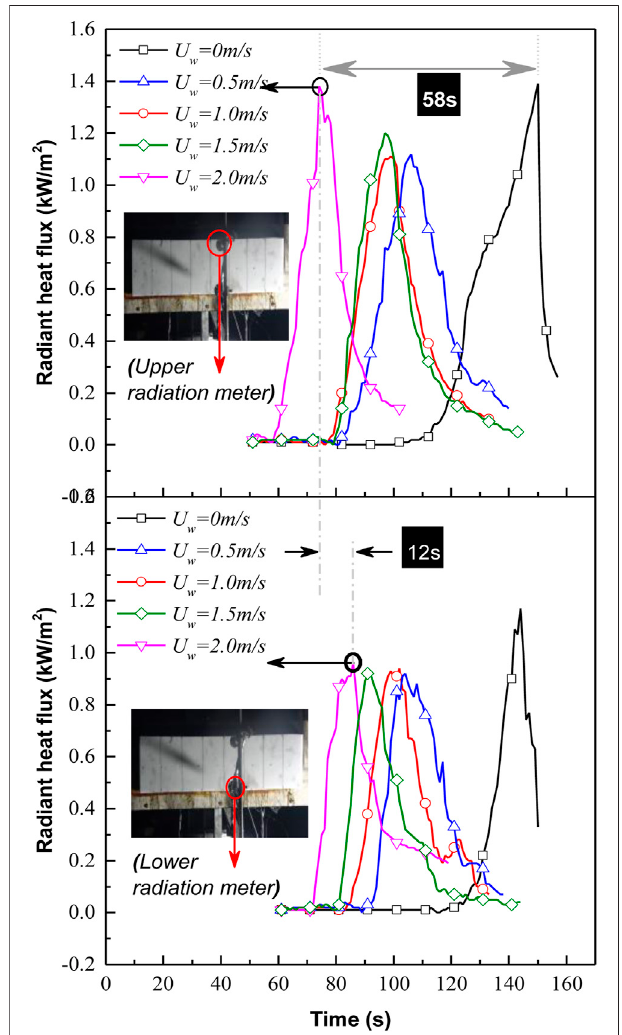
FIGURE5| Temperature pro fi leon thesurface ofthe FPU sampleunder the conditions of U w (cid:1) 0 m / s (A) and U w (cid:1) 2.0 m / s (B) . FIGURE 6 | Distribution of radiant heat fl ux on the upper and lower side of the horizontal FPU under different lateral wind speeds.